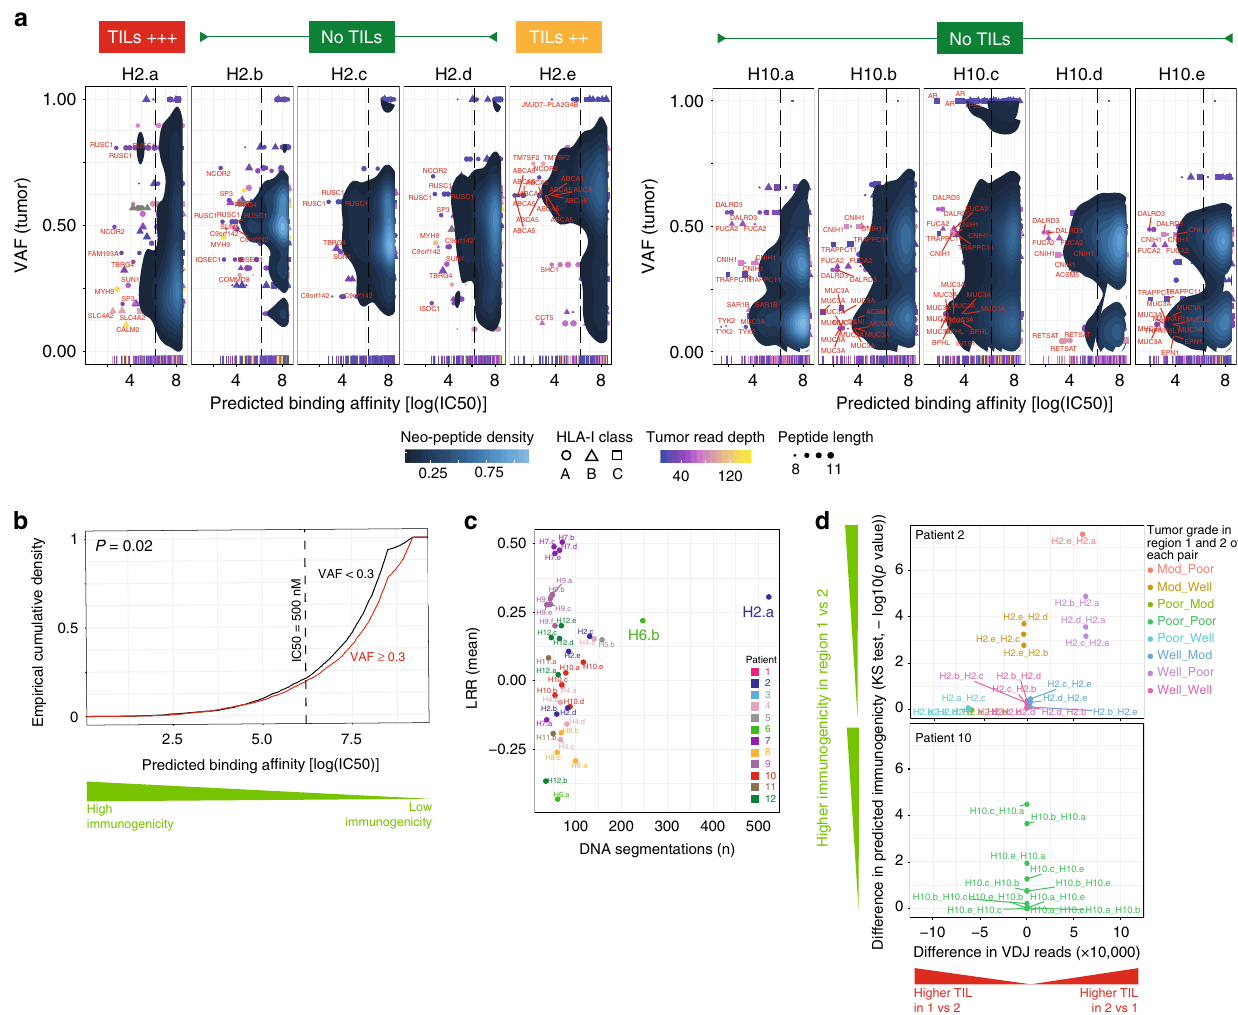
Fig. 3 Neoantigen binding af fi nity. a 2D density of log-scaled peptide binding af fi nity as a function of the VAF of somatic mutations across regions of P10 and P02. Dotted line depicts 50% inhibitory concentration (IC50) = 500 nM (lower IC50 means stronger binding and higher immunogenicity, HLA-I class A: circle; HLA-I class B: Triangle; HLA-I class C: square). b Empirical cumulative density plot of log-scaled binding af fi nity distribution for